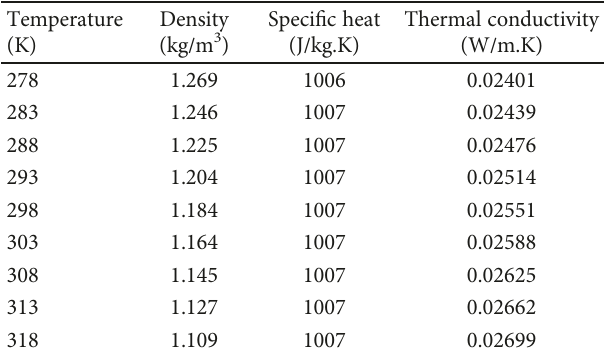
Table 1: Material properties for the air (1 atm) [19].